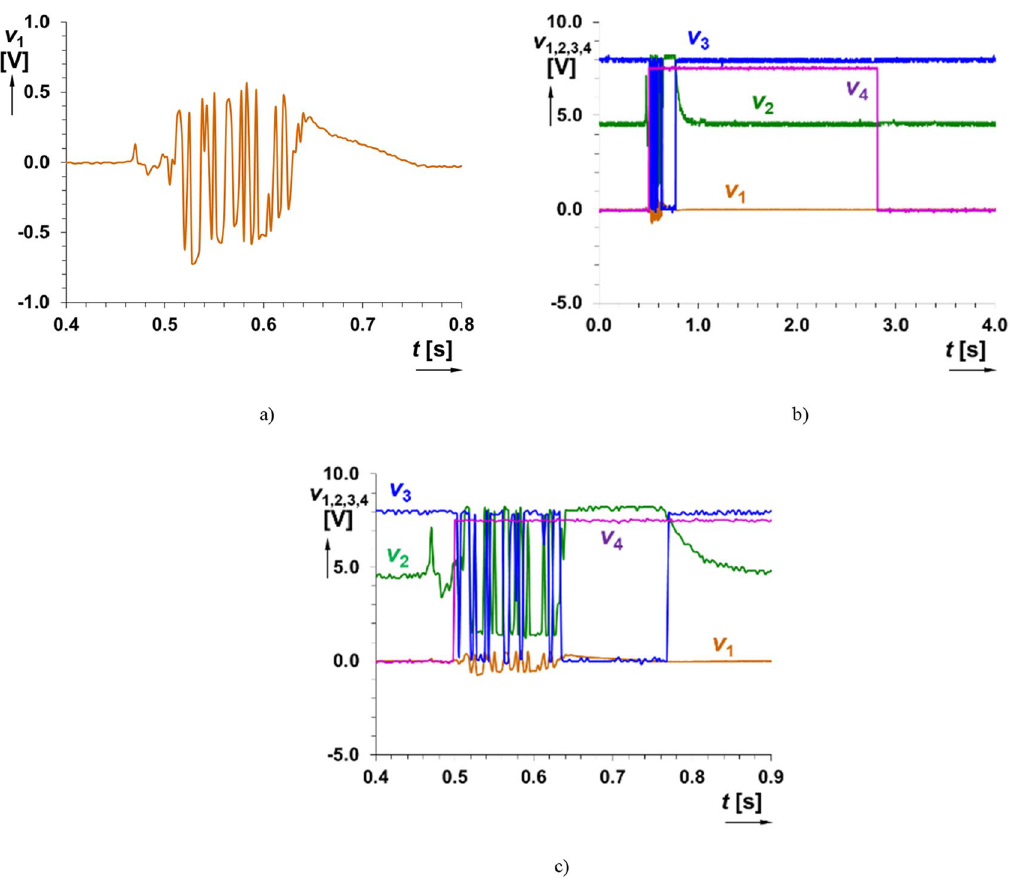
Figure 8. Time domain response of the readout system on direct hit on microphone (signal intentionally limited and level overridden): ( a ) detail on the signal at the output of microphone ( v 1 ( t )), ( b ) all indicated outputs of the system and ( c ) detail on